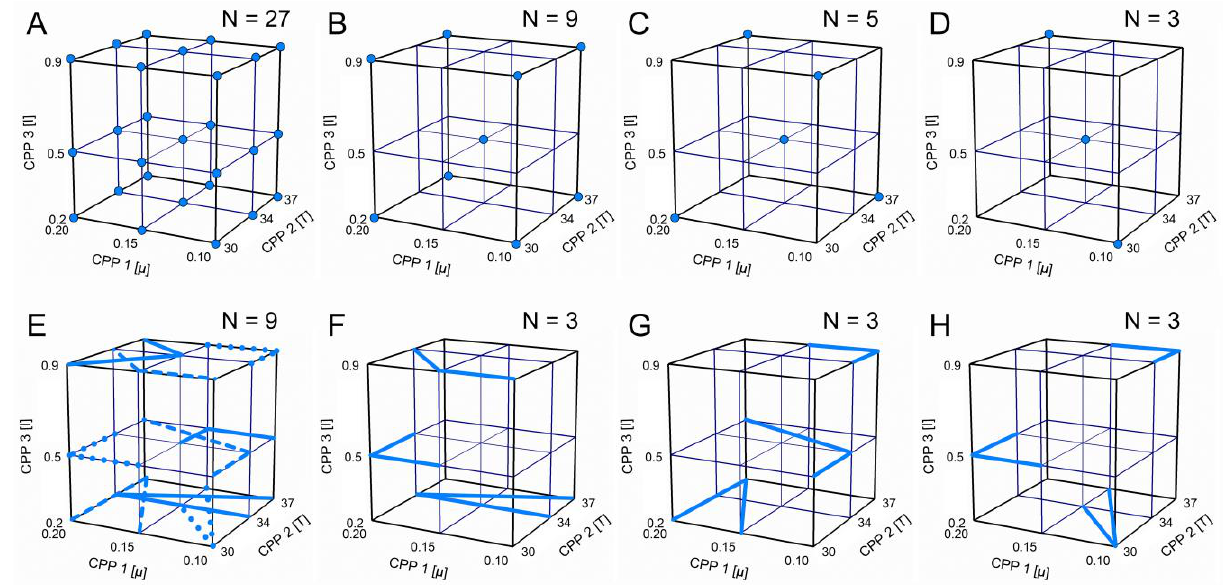
Figure 3. Approaches with varying initial data sets to set up the digital twin for model-based DoE. To find the best CPP combination in the given design space, different approaches with varying initial numbers of experiments were used (blue circles and lines). The full factorial DoE without the need for comprehensive modeling ( A ) was consulted in addition to fractional factorial DoEs with nine ( B ) and five ( C ), as well as a minimal approach using three ( D ), initial static cultivations. Model-based DoE approaches using iDoE cultivations were performed with the complete iDoE data set ( E ) and three fractional iDoEs ( F – H ).